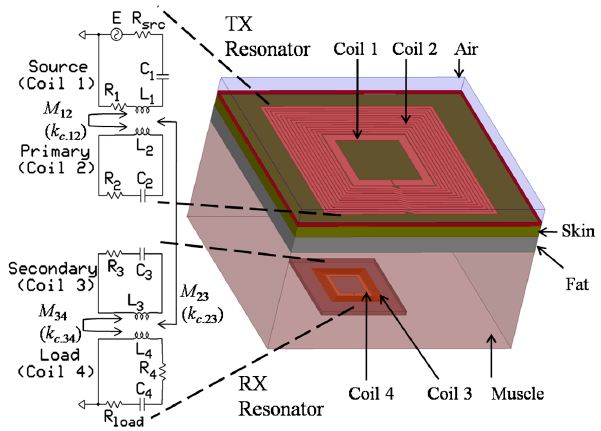
Figure 1. Simplified physical and electrical configuration of a fully planar WPT in a human tissue medium. tissue